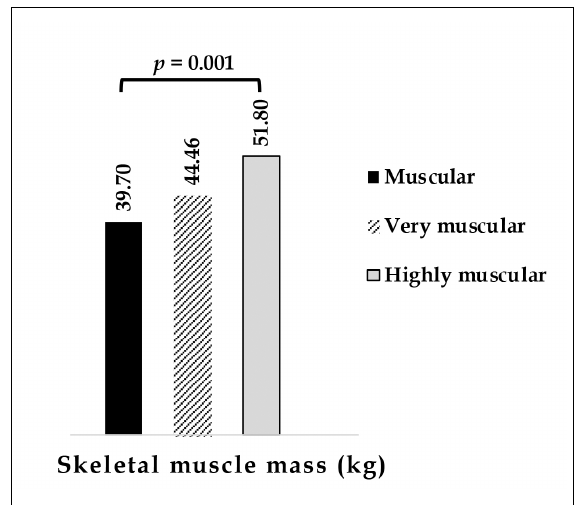
Figure 2. Differences in SMM between the BMI groups